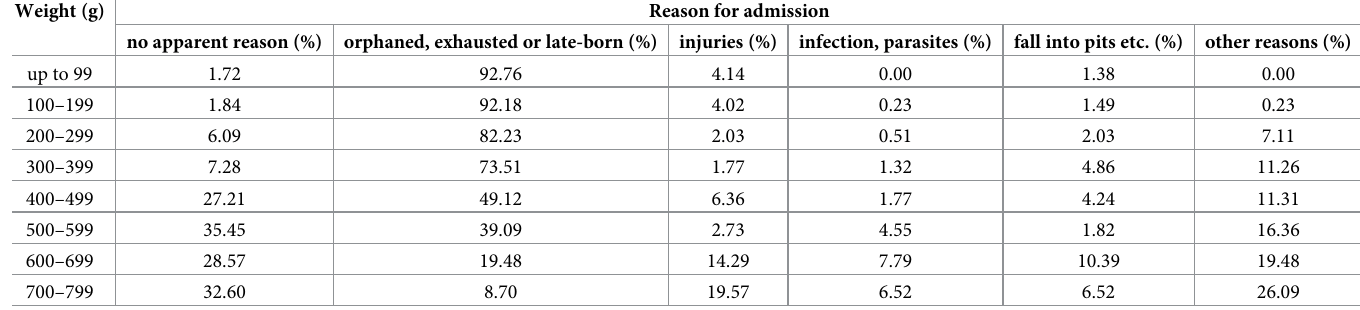
Table 4. Percentage of hoglets unnecessarily brought and those requiring human care admitted and subsequently released from the rescue centers depending on weight. Weight (g) Reason for admission no apparent reason (%) orphaned, exhausted or late-born (%) injuries (%) infection, parasites (%) fall into pits etc. (%) other reasons (%) up to